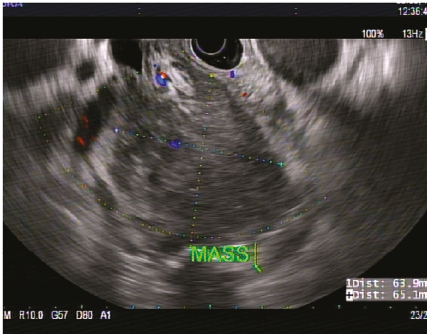
Figure 2: Endosonographic image demonstrating a well-defined round, hypoechoic mass, measuring 65 mm × 64 mm in maximal cross- sectional diameter.